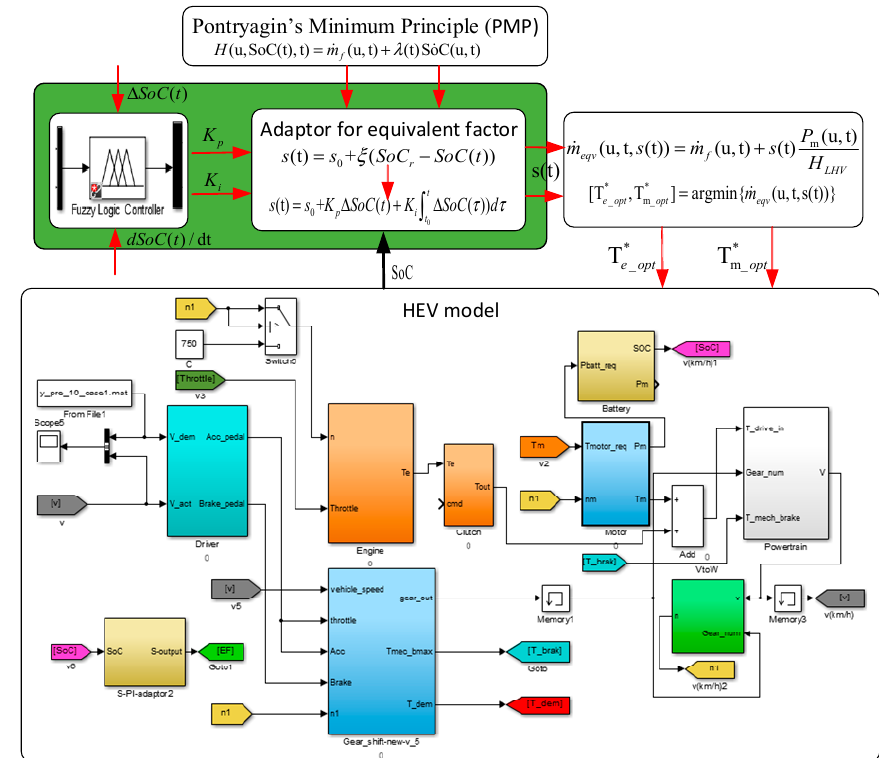
Figure 10. The overall structure of the proposed energy management.